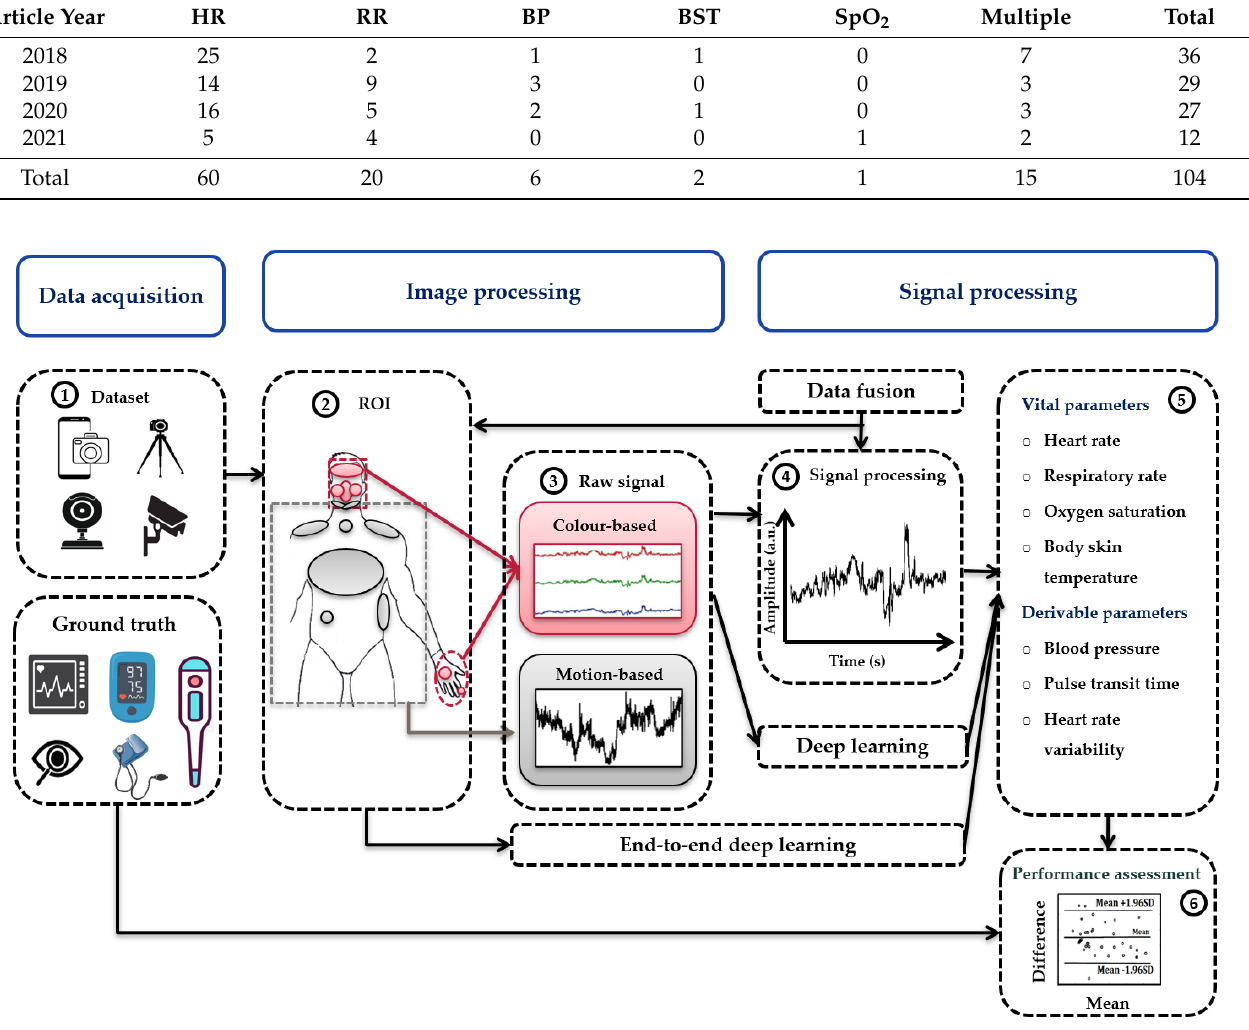
Figure 2. General flow diagram of vital sign measurements from video/image data.